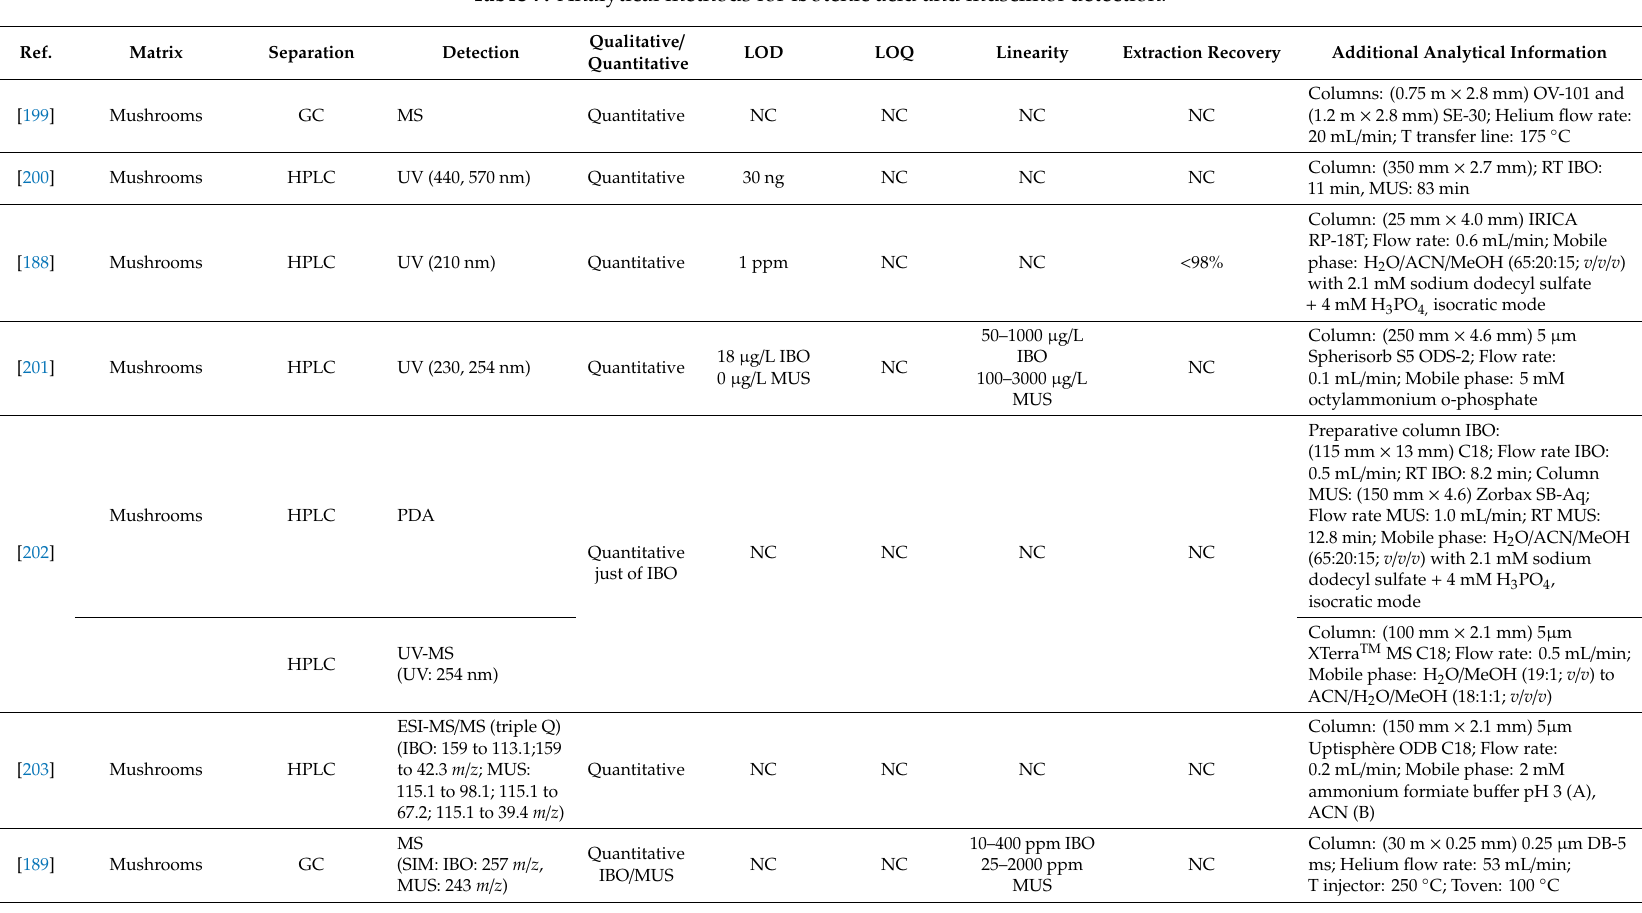
Table 7. Analytical methods for ibotenic acid and muscimol